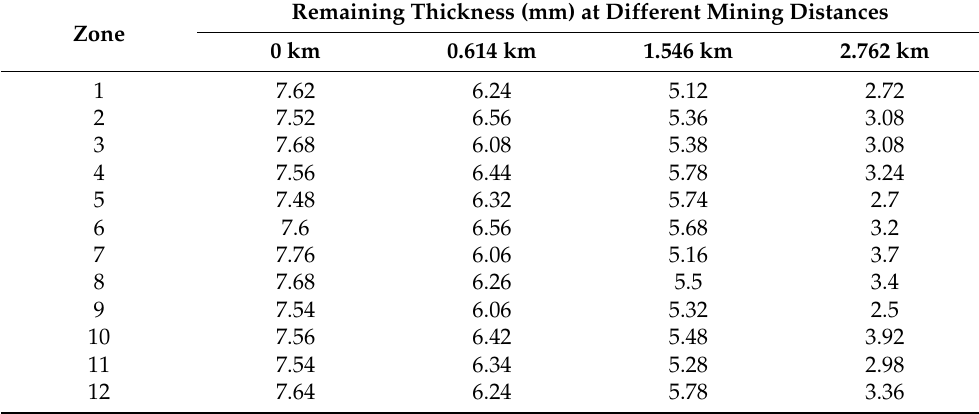
Table 5. The remaining thickness for the wear-resistance structure on the screw conveyor. Zone